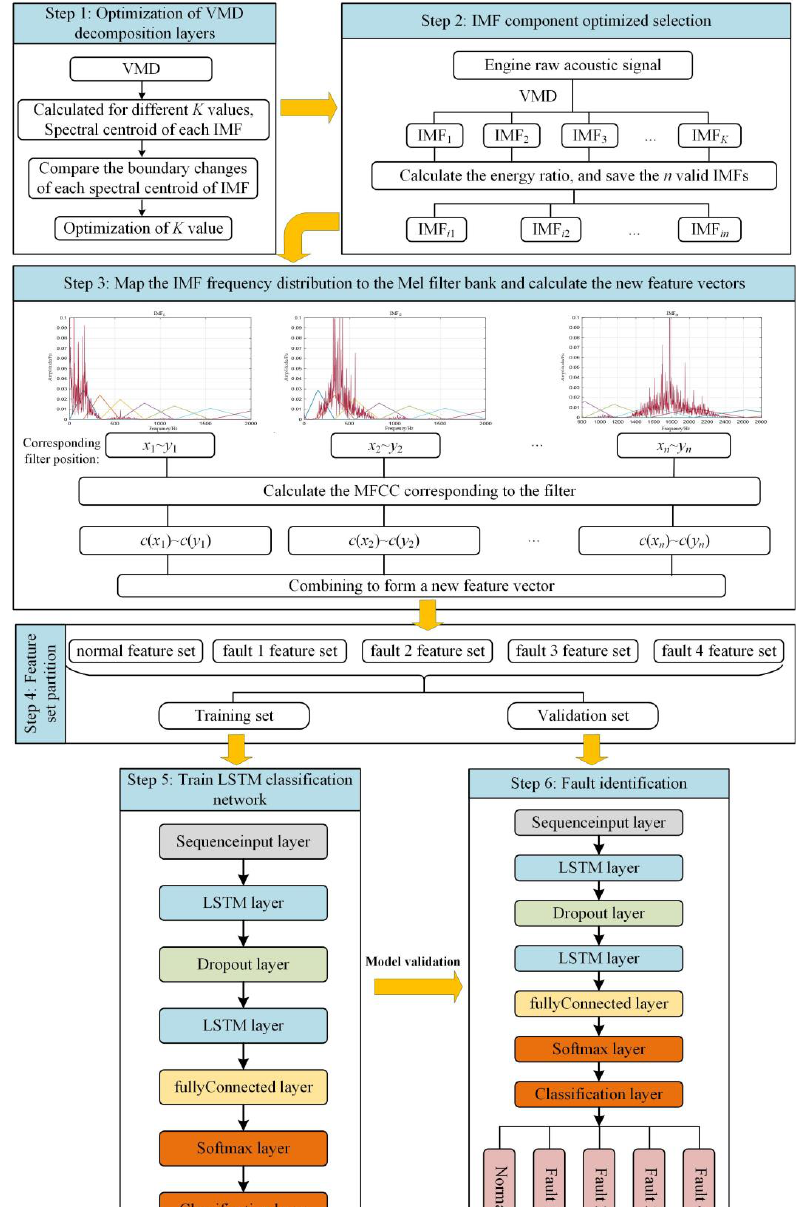
Figure 5. Full flowchart of fault diagnosis.